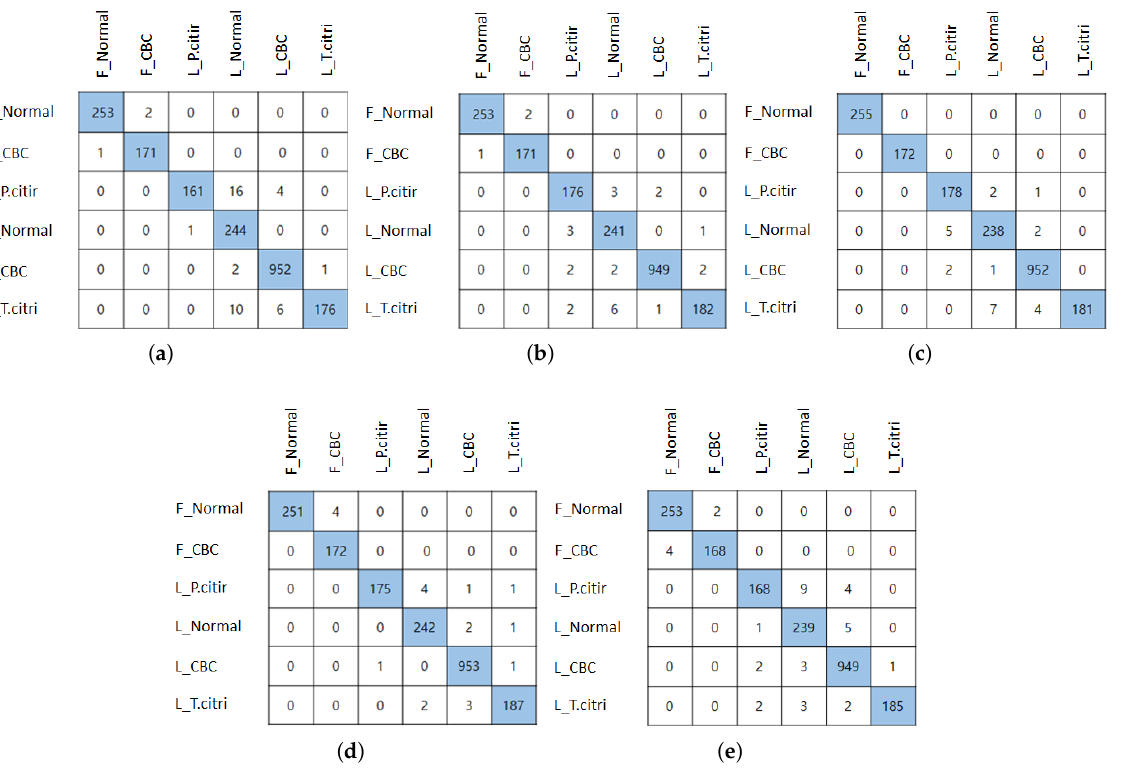
Figure 4. Confusion matrix of test dataset ( a ) VGGNet16. ( b ) ResNet50. ( c ) DenseNet161. ( d ) Efficinet- Net_b0. ( e )